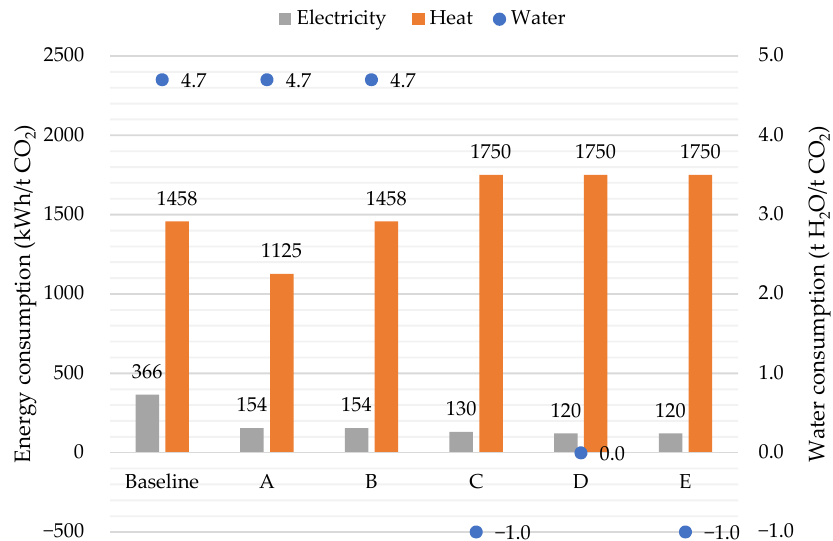
Figure 6. DAC electricity, heat and water consumption for each scenario with applied synergies. Negative values in water column show excess water production.